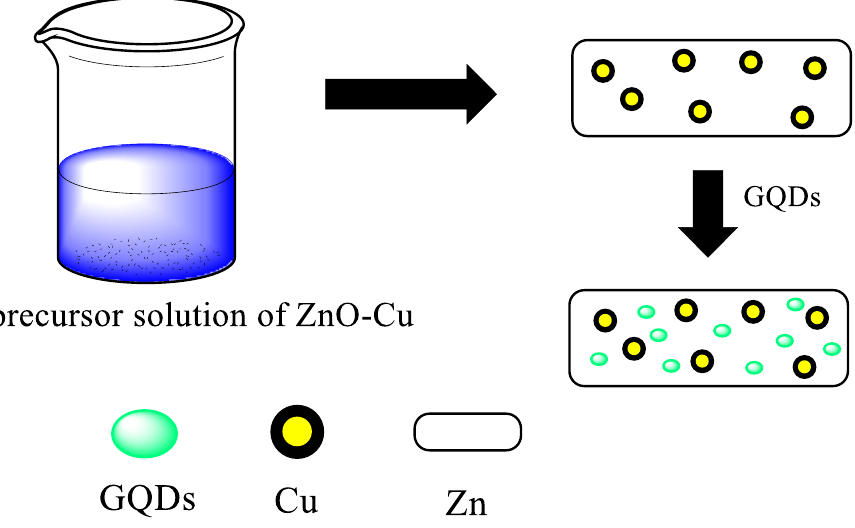
Figure 17. Schematic representation for the surface modification of GQDs.